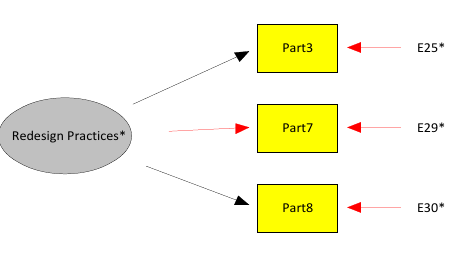
Figure 5. Model 2c – Empowerment Figure 6. Model 2d –